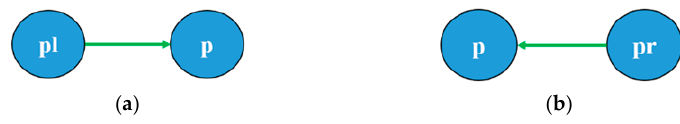
Figure 6. ( a ) First pass, from left to right; and ( b ) second pass, from right to left [19].